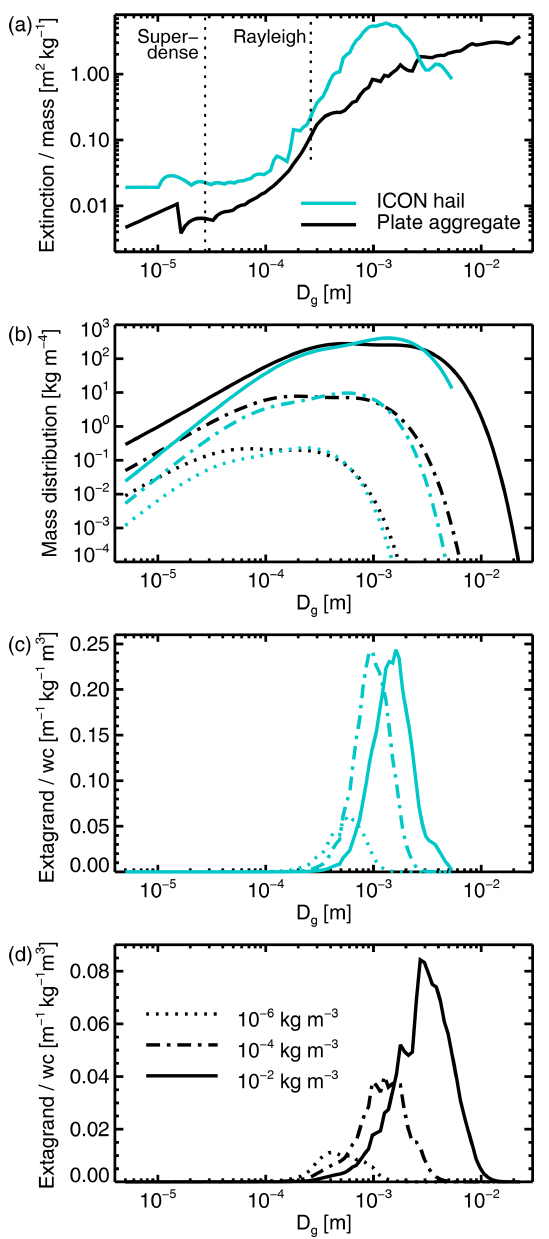
Figure 6. Integration of single-particle extinction over the PSD: (a) single-particle extinction per unit particle mass σ e (D g )/m(D g ) ; (b) mass distribution m(D g )N (cid:48) g (D g ) ; (c) contri- bution to total extinction (“extagrand”) normalised by water content σ e (D g )N (cid:48) g (D g ) d D g /l for ARTS ICON hail; (d) as (c) but for ARTS plate aggregate. The F07 T PSD has been used with the “new” inte- gration, at a temperature of 253K and a frequency of 190.31GHz. The extended integration range for cloud ice (down to 5 × 10 − 6 m) has been used for illustrative purposes. Dotted lines on (a) corre- spond to, first, the largest sizes for which the plate aggregate is super-dense; second, the largest size for which Rayleigh scattering would be an appropriate model for the ICON hail